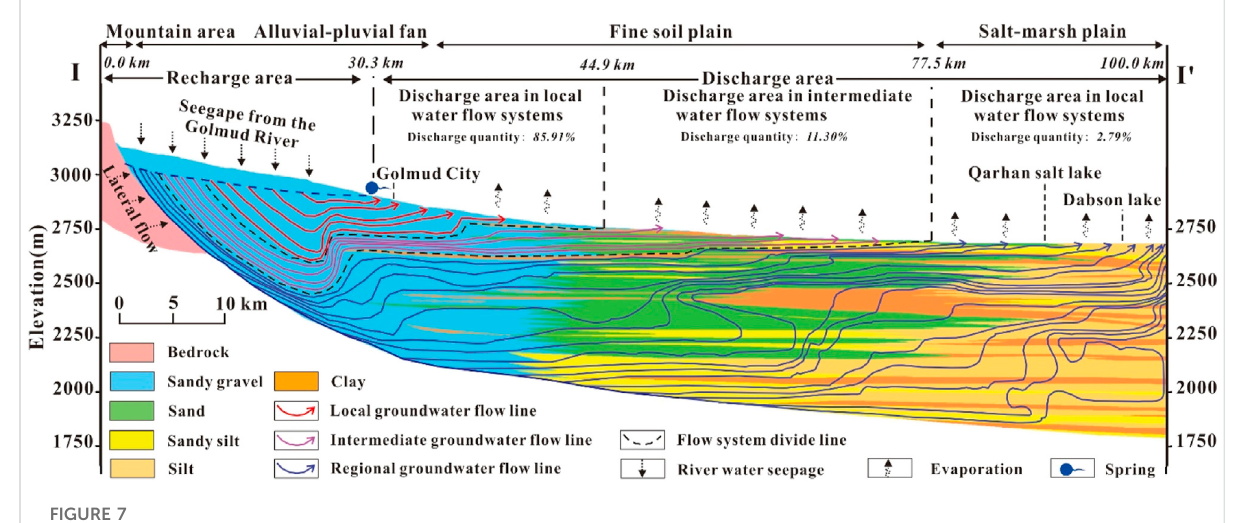
FIGURE 7 The groundwater fl ow pattern of the Golmud river watershed after climate